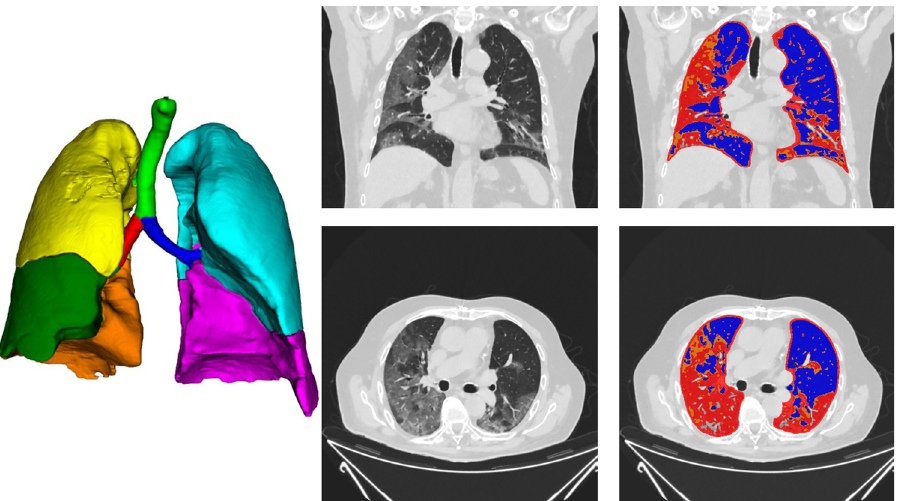
Fig 1. The YACTA software performed a fully automatic segmentation of airways, vessels and lung parenchyma of an 84y/o male with extensive lung infiltrates who received high-flow oxygen therapy and invasive ventilation. In the course of the disease he developed renal insufficiency, septic shock and died 21 days after symptom onset and 8 days after hospital admission. Consolidations are shown in red, ground-glass opacities in orange, healthy lung in blue, vessel voxels in grey are excluded. The 3D rendering shows the lung segmentation with their segmented lobes in different colors, in the statistical evaluation the lung parenchyma was considered as a whole.